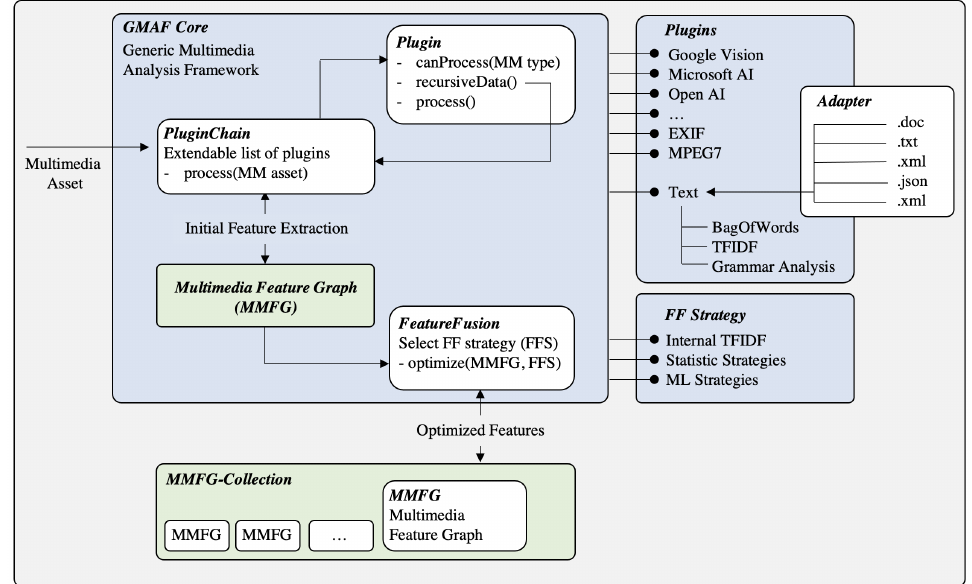
Figure 8. Feature fusion and plugin chain facilities in the